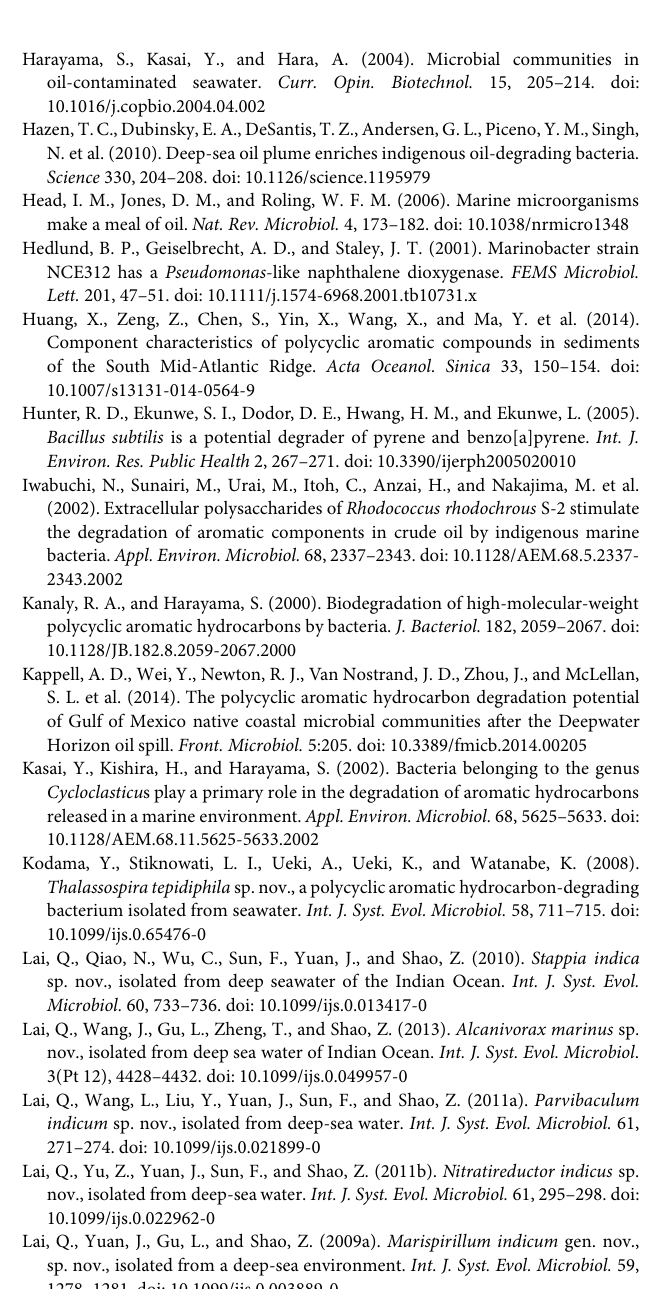
FIGURE S1 | Sampling site IR-CTD5 (The map based on NOAA topography). The solid red circles are hydrothermal vent fields previously detected. IR-CTD5 was in the B-B’ section, where plume 2 was found by anomalies (German et al., 1998). Edmond and Kairei are confirmed vent sites. FIGURE S2 | Community structures of the PAH-degrading consortia growing with 4-PAH mixture in 20 days. Derived from water samples of IR5-2 to IR5-9 after PAH enrichment, with water depths of 4696, 4546, 4396, 4296, 4196, 4146, 4096 and 3946 m, and 40–820 m above the sea floor. FIGURE S3 | Community structures of the PAH-degrading consortia growing with phenanthrene in 20 days. Treatments were in parallel with those in Figure S2, except using phenanthrene as a sole carbon